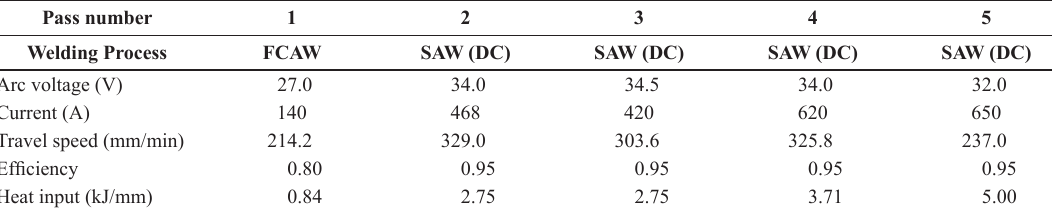
Table 4: Welding parameters for one wire SAW (S-SAW).